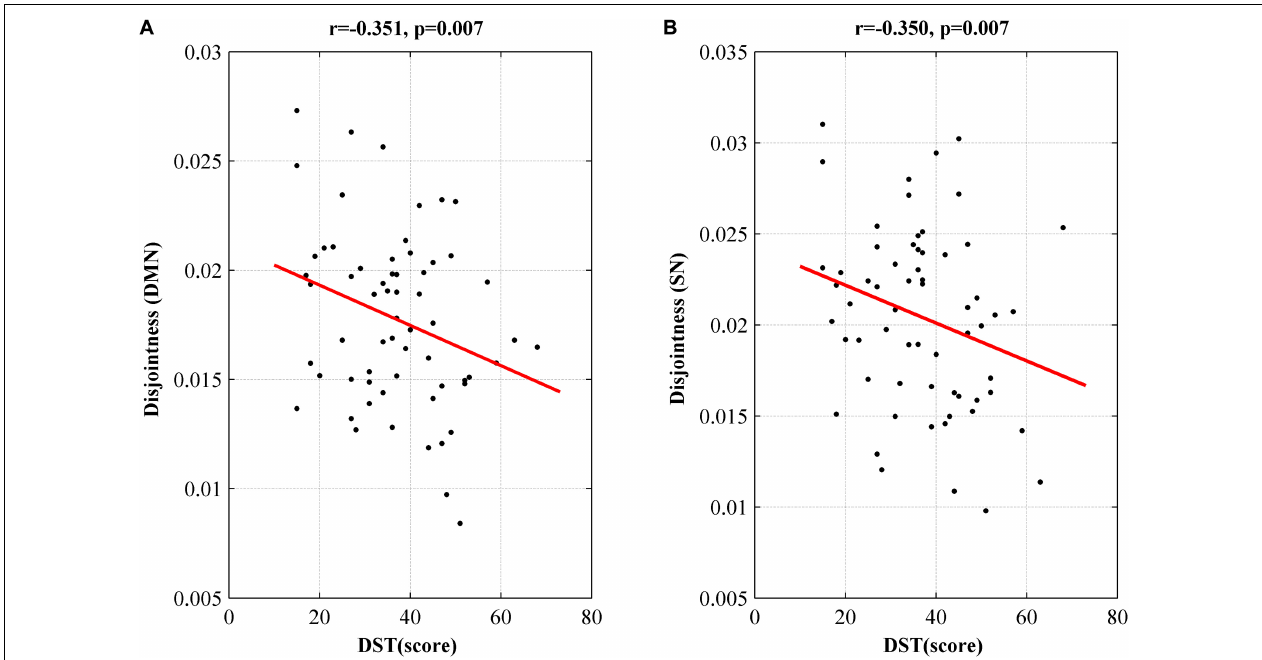
FIGURE 4 | Networks showing significant correlation of disjointness metric with DST score in DMN (A) and SN (B) . DMN, default model network; SN, salience network; DST, digit symbol test; MHE, minimal hepatic